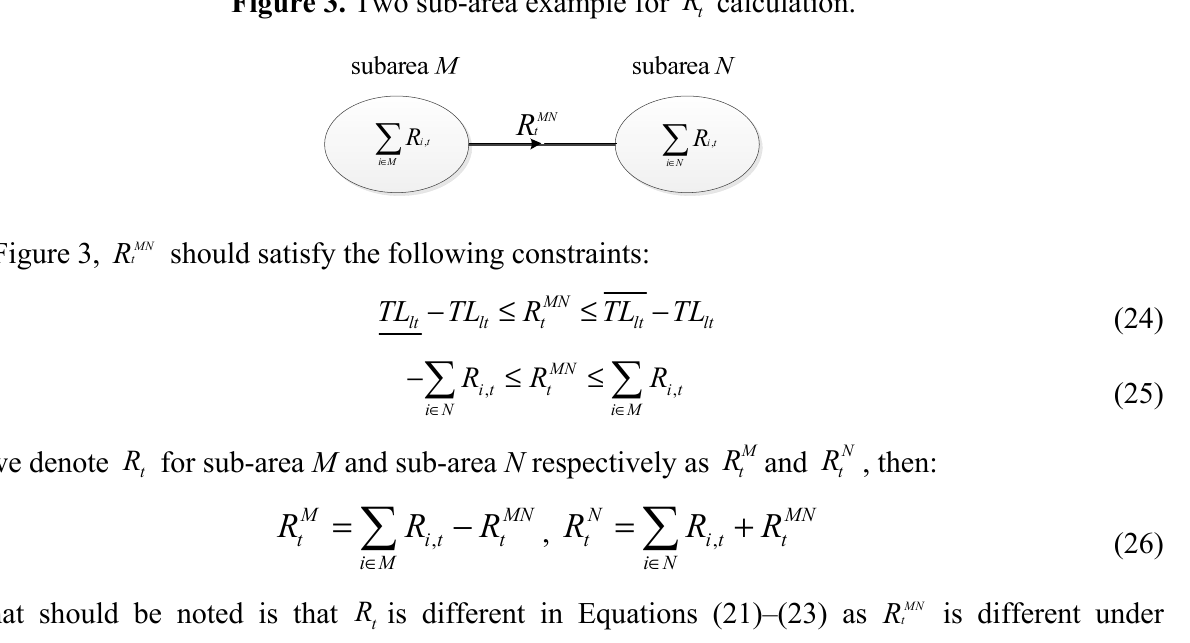
Figure 3. Two sub-area example for